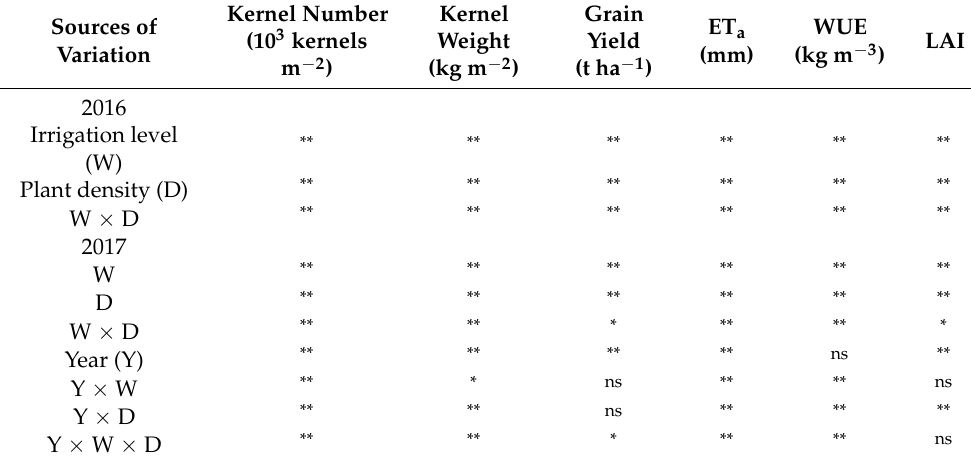
Table 3. Analysis of variance significance levels for the main factors, irrigation level, and planting den- sity, and the two-way interactions for grain yield, kernel number, kernel weight, evapotranspiration, water use efficiency, and LAI in 2016 and